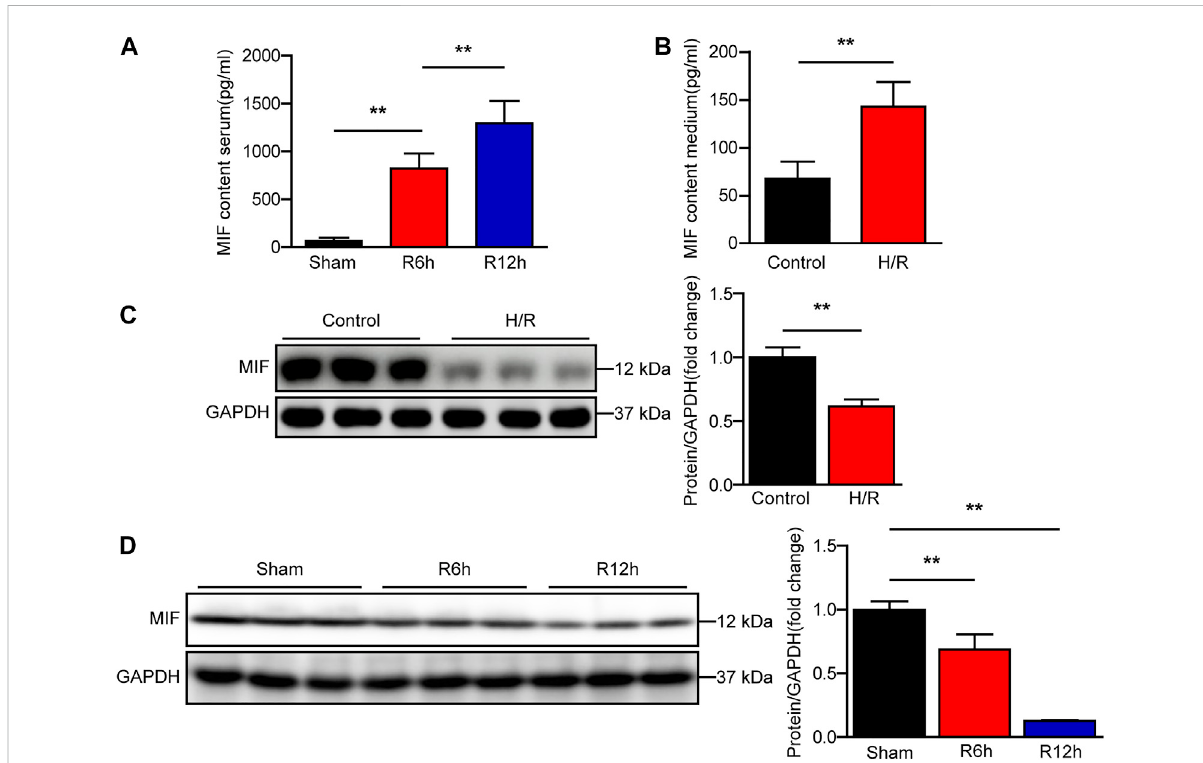
FIGURE 1 MIF expression is signi fi cantly increased in serum of mice subjected to hepatic I/R injury. (A) ELISA detection of MIF level in serum of mice at 6and12 hafterhepatic IRsurgery ( n =6pergroup). (B) ELISAdetection ofMIFlevel inmedium ofhepatocytes subjectedto H/Rtreatment( n =3per group). (C) MIF protein expression in cultured hepatocytes challenged by H/R treatment. GAPDH served as the loading control. Representative of three independent experiments. (D) MIF protein expression in the liver of mice at 6 and 12 h after hepatic IR surgery (n = 6 per group). GAPDH served as the loading control. All data are presented as the mean ± SD. Levels of statistical signi fi cance are indicated as ** p < 0.01. For statistical analysis, one-way ANOVA with Bonferroni ’ s posthoc analysis or Tamhane ’ s T2 posthoc analysis and two-tailed Student ’ s t test were